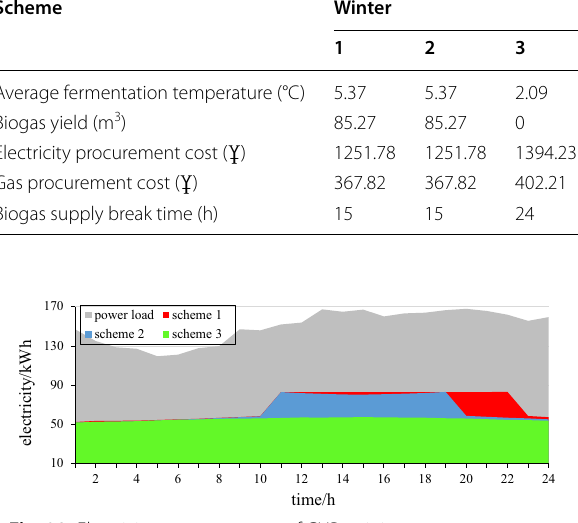
Fig. 20 Electricity energy outputs of CHP unit in